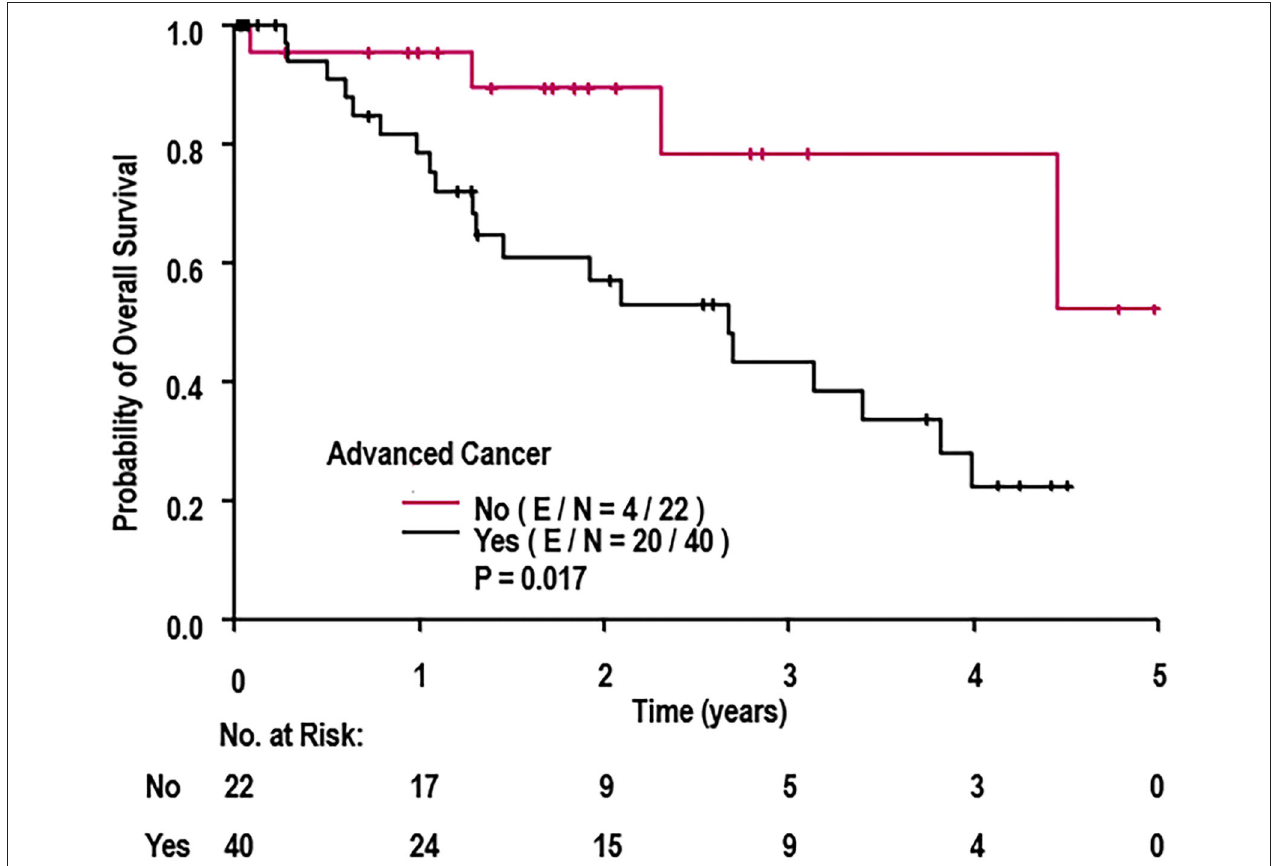
FIGURE 6 | Overall survival of cohort when stratified by cancer prognosis (early vs. advanced). E, events; N, number of patients; OS, overall survival. P -value determined from log-rank